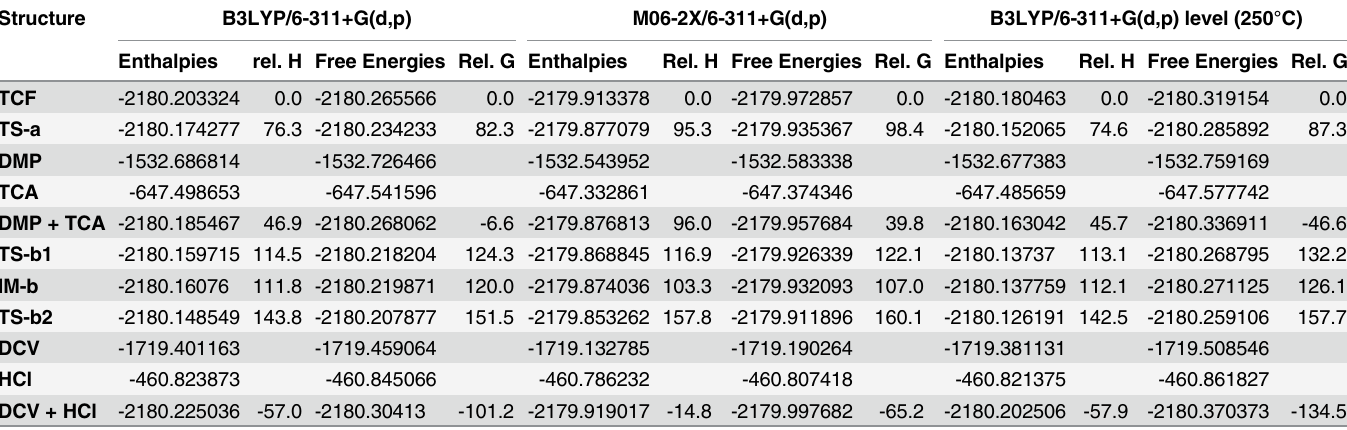
which has a hydroxyl group bonding to the P atom. IM-b has also been obtained in the TIC of Table 1. Enthalpies (H, in Hartree), relative Enthalpies (rel. H, in kJ mol -1 ), Free Energies (G, in Hartree) and relative Free Energies (rel. G, in kJ mol -1 ) of the structures, obtained at the B3LYP/6-311+G(d,p) level, the M06-2X/6-311+G(d,p) level, and the B3LYP/6-311+G(d,p) level (250°C),